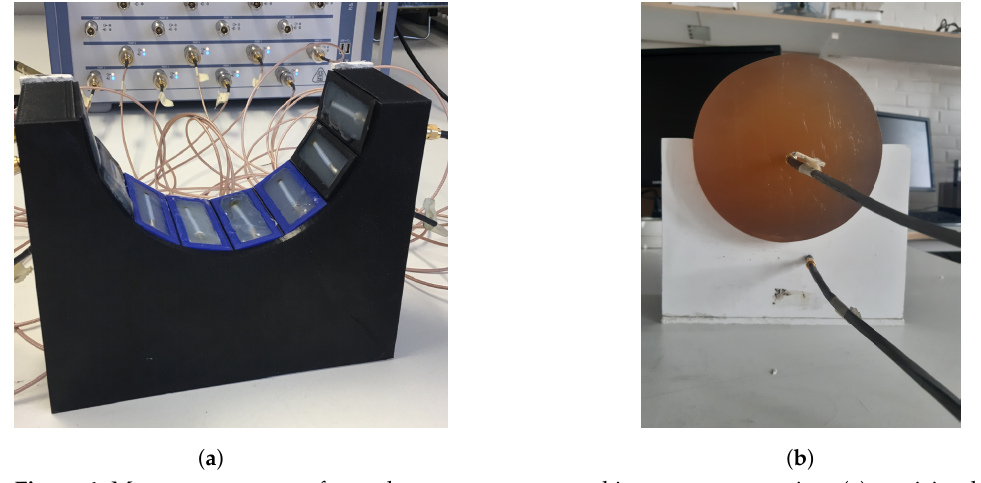
Figure 4. Measurement setup for probe measurements and image reconstruction: ( a ) semicircular antenna array consisting of 8 antennae; ( b ) muscle phantom in the antenna array, with